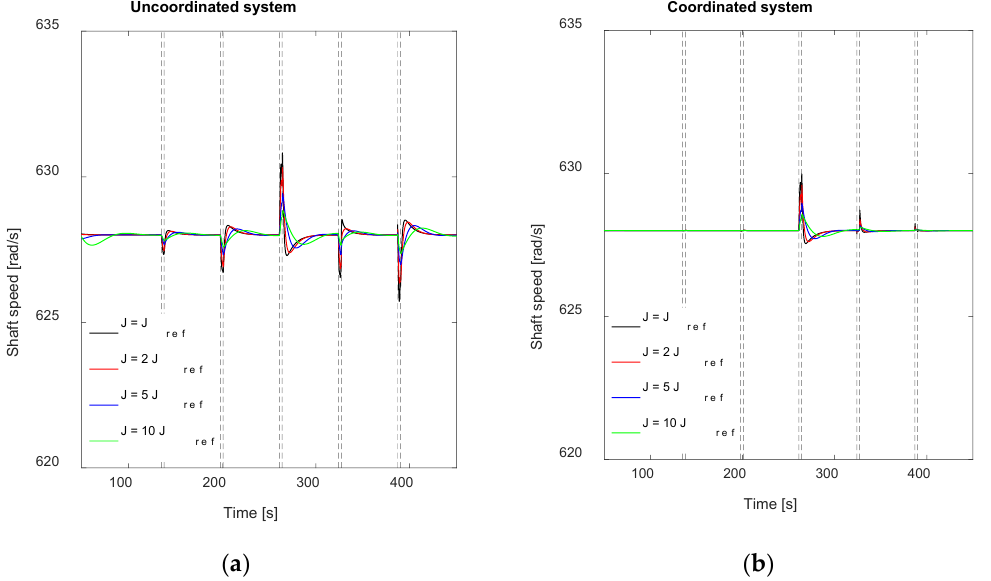
Figure 14. Influence of shaft inertia for a given power split ratio: ( a ) uncoordinated system, ( b ) coordinated system.